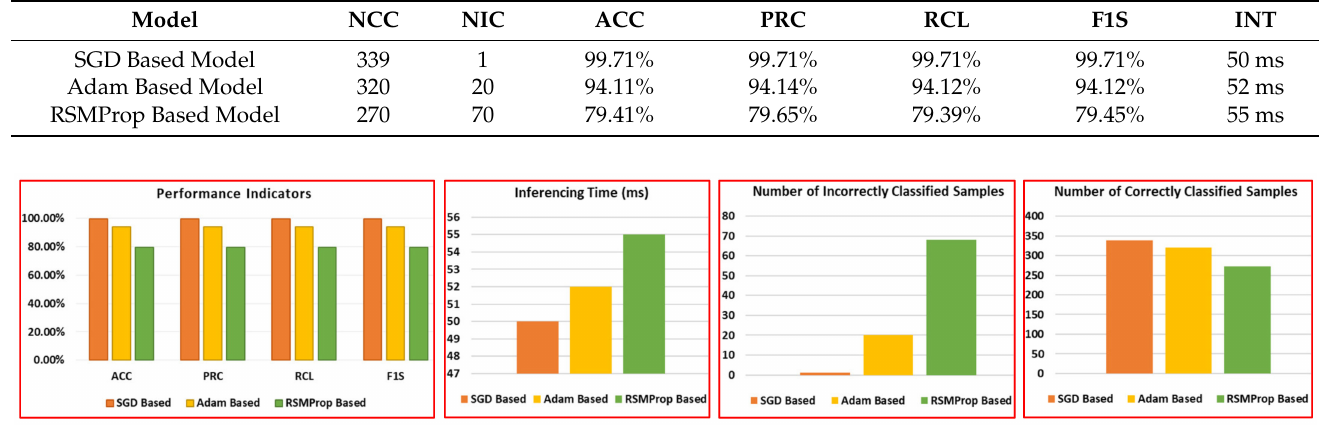
Figure 8. Comparing the performance indicators of the three model-based